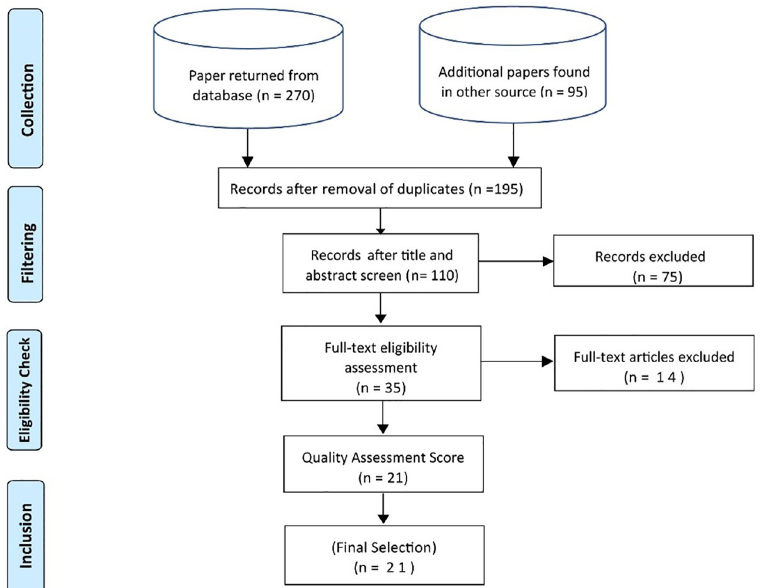
Fig 3. PRISMA flow diagram for search process and selection procedure.